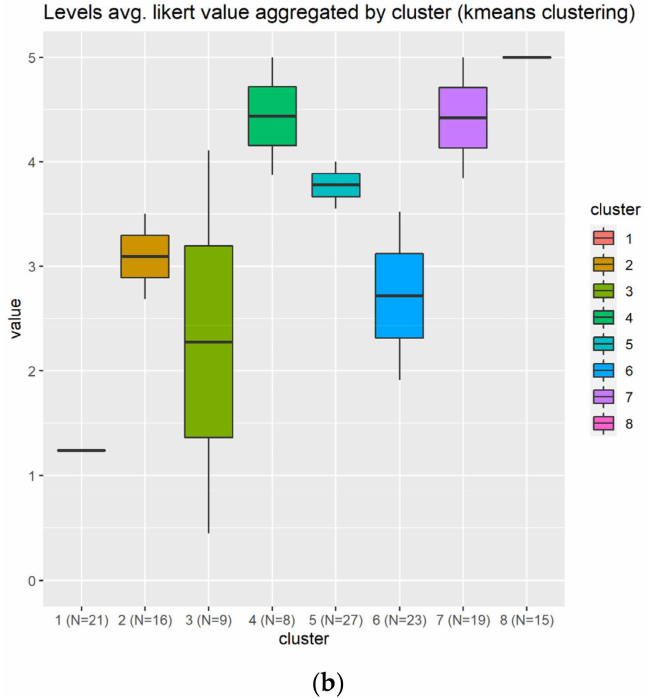
Figure 14. Results for leveling elements. Eight cluster generated, as can be seen in subfigure ( a ), where three of them are important according to the boxplots in subfigure ( b